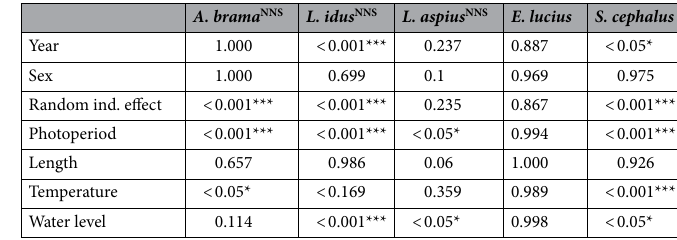
Table 3. P value for individual components of the model (1). NNS Non-native species. *P ≤ 0.05; ***P ≤